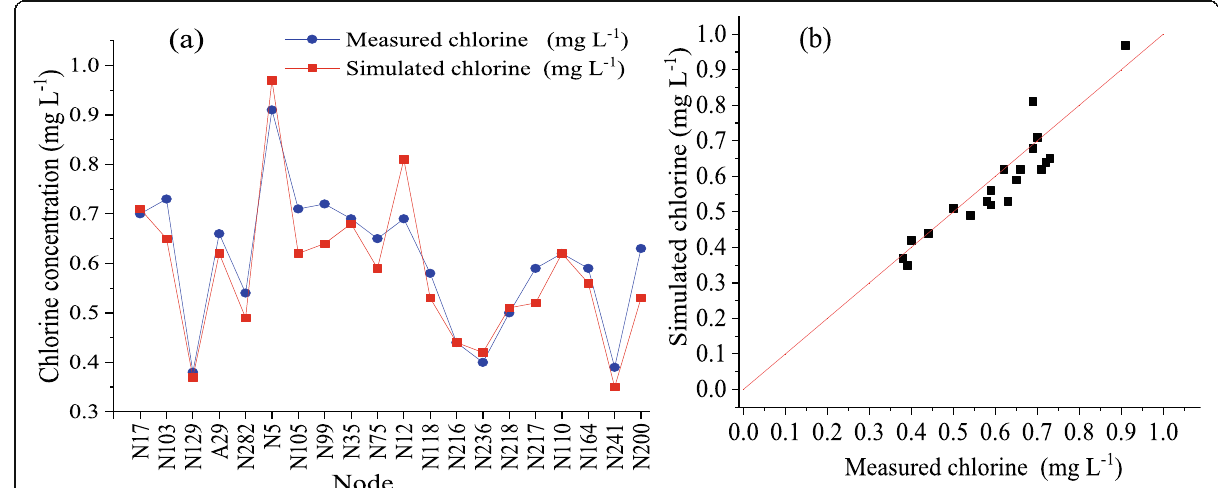
Fig. 5 a Comparison of computed and measured chlorine concentration during the calibration b Pearson correlation results between computed and measured chlorine concentration during the calibration